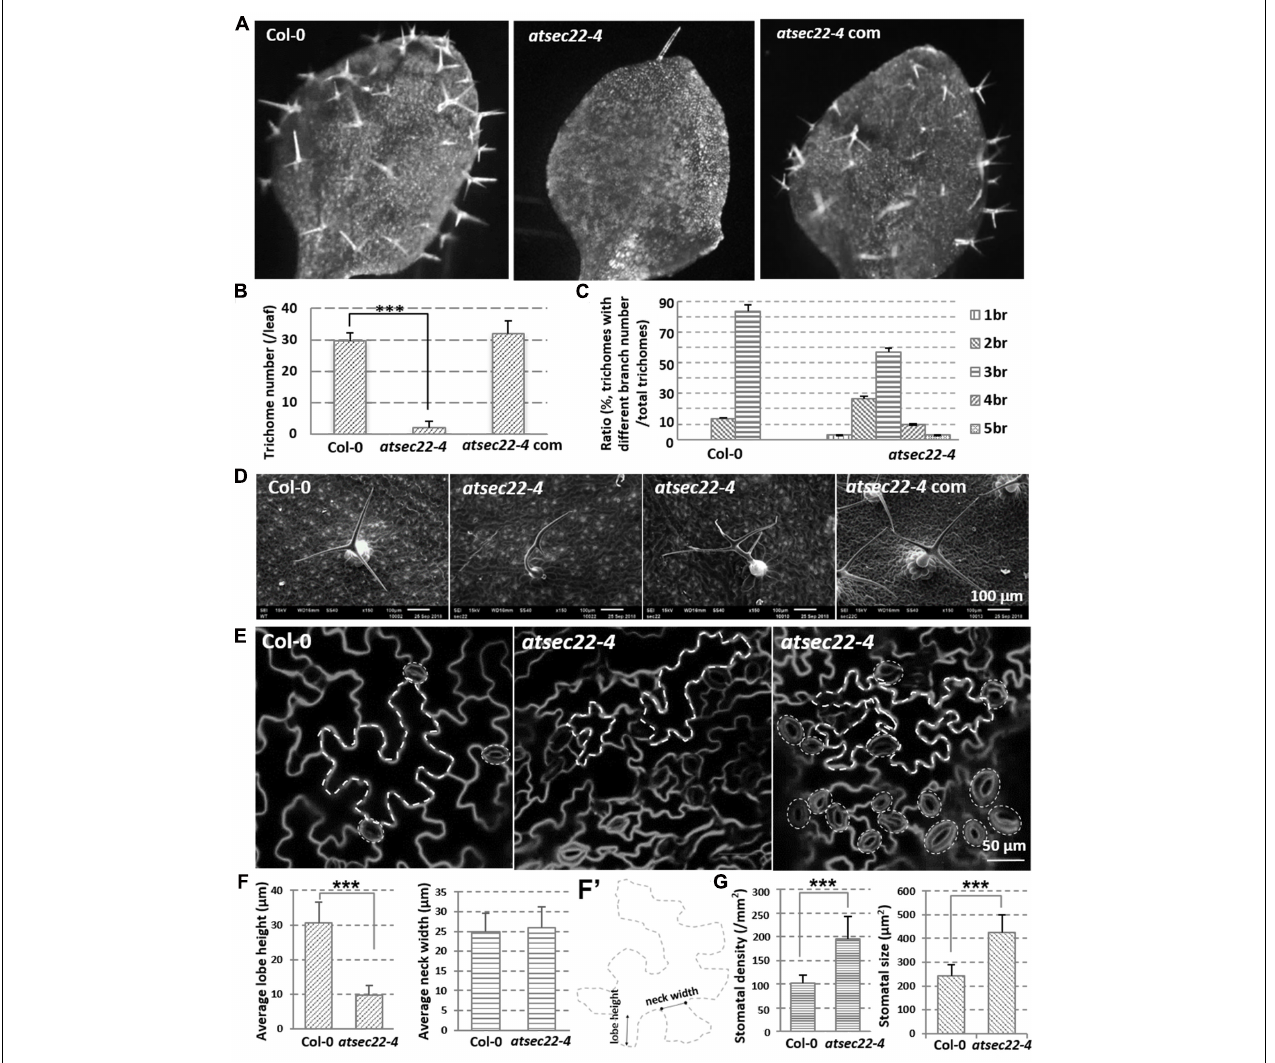
FIGURE 2 | Morphology of epidermal cells was abnormal in atsec22-4. (A) Images of the first true leaves from 12-day-old seedlings. Images were the same scale. (B) Statistics of leaf trichome number in panel (A). n Col − 0 = 12, n atsec 22 - 4 = 20 leaves. *** P < 0.001. Significance was evaluated by Student’s t test. (C) Statistics of leaf trichomes with different branch number from seven-week-old plants. n Col − 0 = 66, n atsec 22 - 4 = 46 trichomes. br, branch. (D) SEM images of 3rd or 4th rosette leaves from seven-week-old plants. (E) FM4-64-labeled shape of pavement cells and stomata in the 4th leaves from 14-day-old seedlings. Scale bars are as shown. (F,F’) The measurement of lobe length and neck width of pavement cells in the middle part of leaves from 14-day-old seedlings. n ≥ 20. Panel (F’) , the line with round dots indicates neck width; the line with arrows indicates lobe height. (G) Statistics of leaf stomata density and size in the middle part of the first pair true leaves from 12-day-old seedlings. For density statistics, 20 slices of an area of 0.02 mm 2 were used; for size statistics, n Col − 0 = 40, n atsec 22 - 4 = 50 stomata. *** P < 0.001. Significance was evaluated by Student’s t